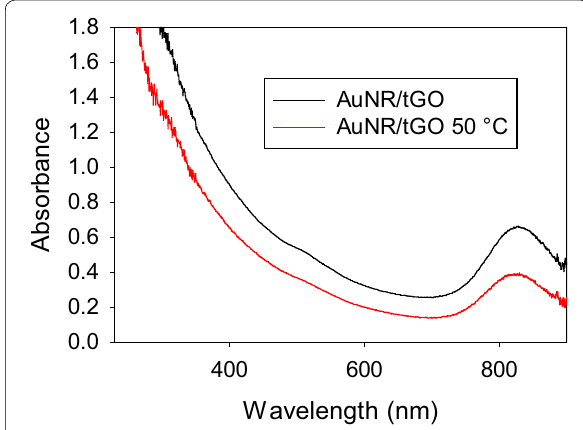
Fig. 8 UV‑vis spectra of cAuNR‑tGO before and after heat treatment at 50